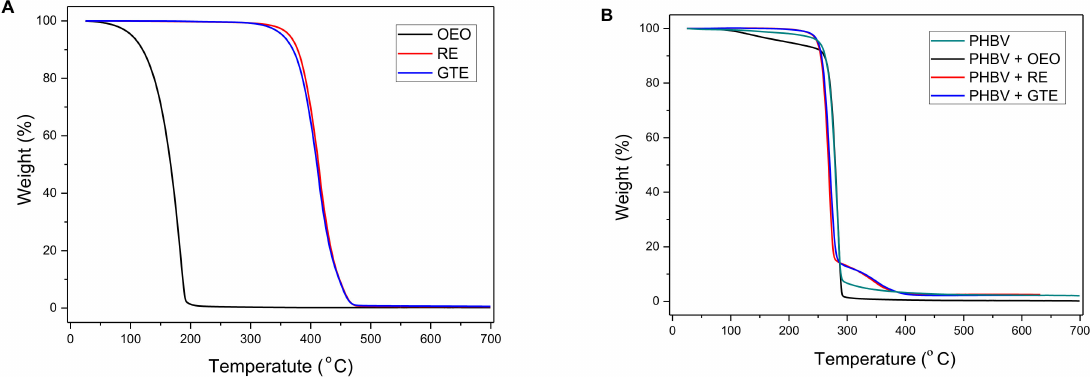
Figure 4. Weight loss as a function of temperature for: ( A ) Oregano essential oil (OEO), rosemary extract (RE), and green tea tree extract (GTE); ( B ) Electrospun films of neat poly(3-hydroxybutyrate-co-3-hydroxyvalerate) (PHBV) and PHBV containing OEO, RE, and